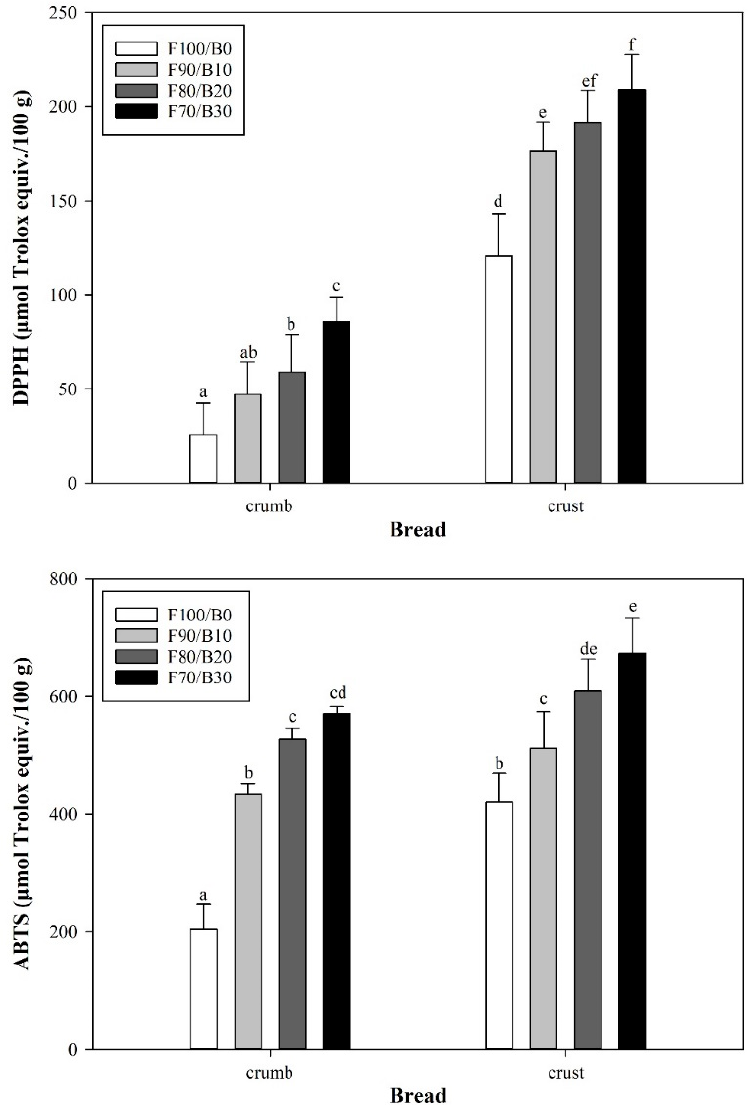
Figure 4. DPPH and ABTS radical scavenging activities of the crumb and crust of the bread formu- lated with the flour–bran blends at different ratios. Bars represent the mean values, and the error bars denote the standard deviation from triplicate measurements. The same letters above the bars are not significantly different ( p < 0.05) according to Tukey’s HSD test.